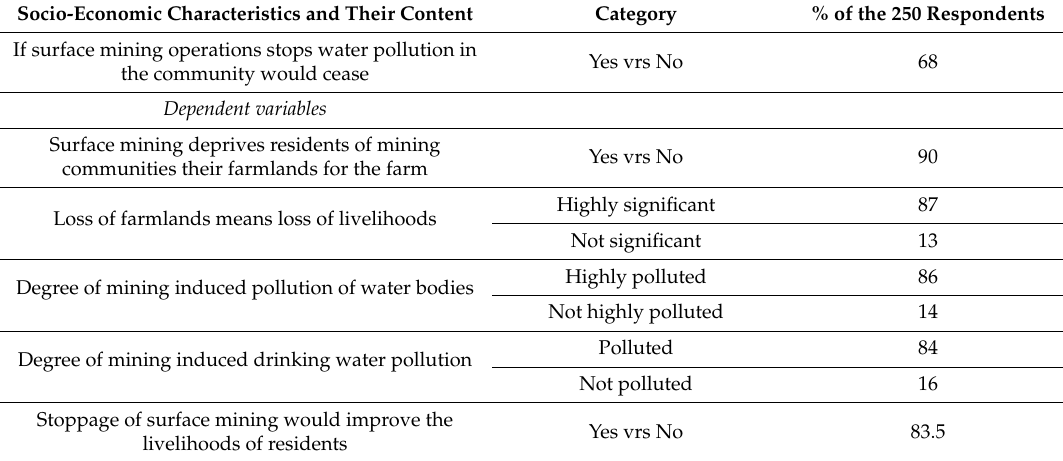
Table 1. Socioeconomic and environmental variables of the perception study, showing questions asked and answers provided by the 250 households.